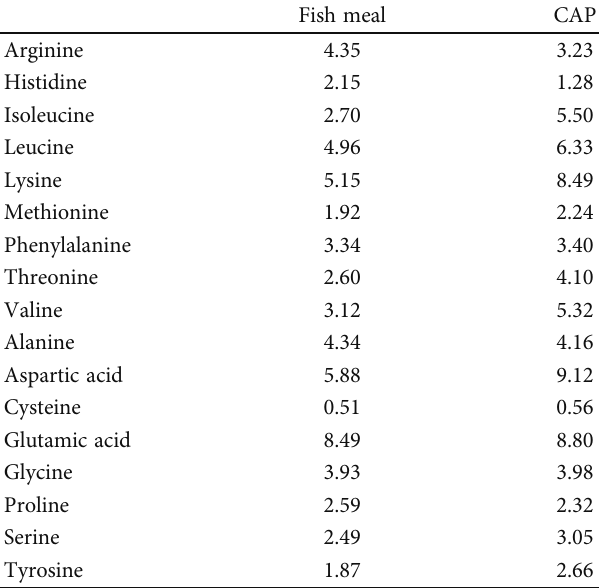
Table 1: Compositions of fi shmeal and the Clostridium autoethanogenum protein (CAP) used in the present study (%, dry matter).